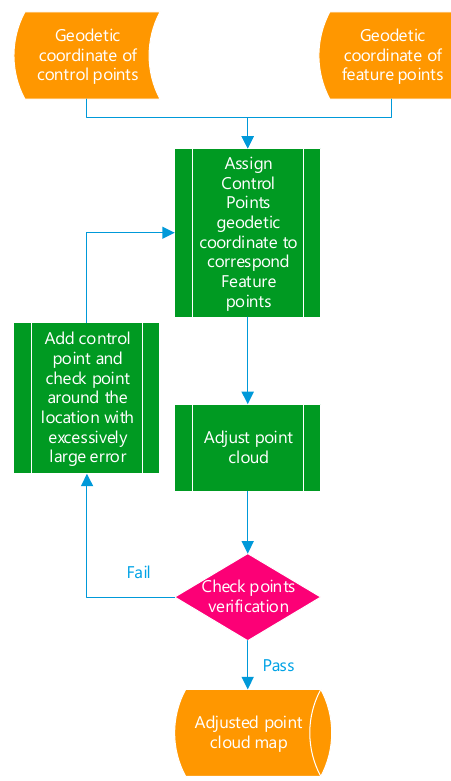
Figure 14. Point cloud adjustment via control